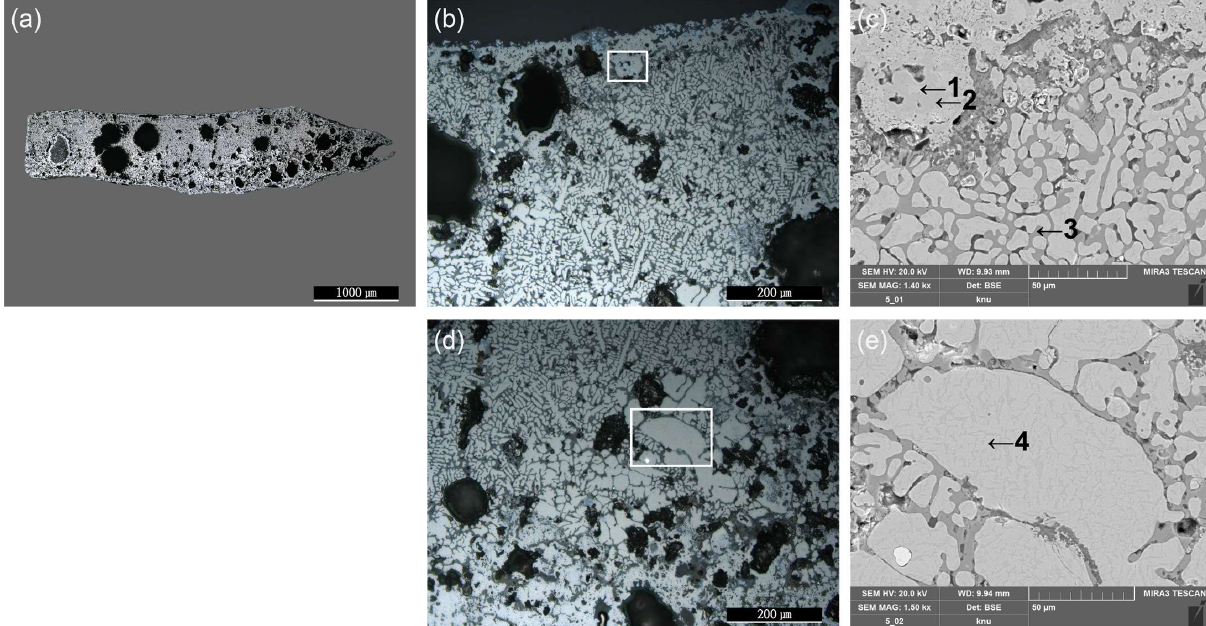
Figure 7. Microstructure and SEM image of flake hammer scale (No. 2): ( a ) whole image, ( b , d ) metallographic microscope detailed image and rectangle is position of the SEM analysis, ( c,e ) position of the SEM image and EDS analysis; 1: wüstite, 2: magnetite, 3: fayalite, 4: wüstite. Table 3. EDS analysis of flake hammer scale (No. 2).